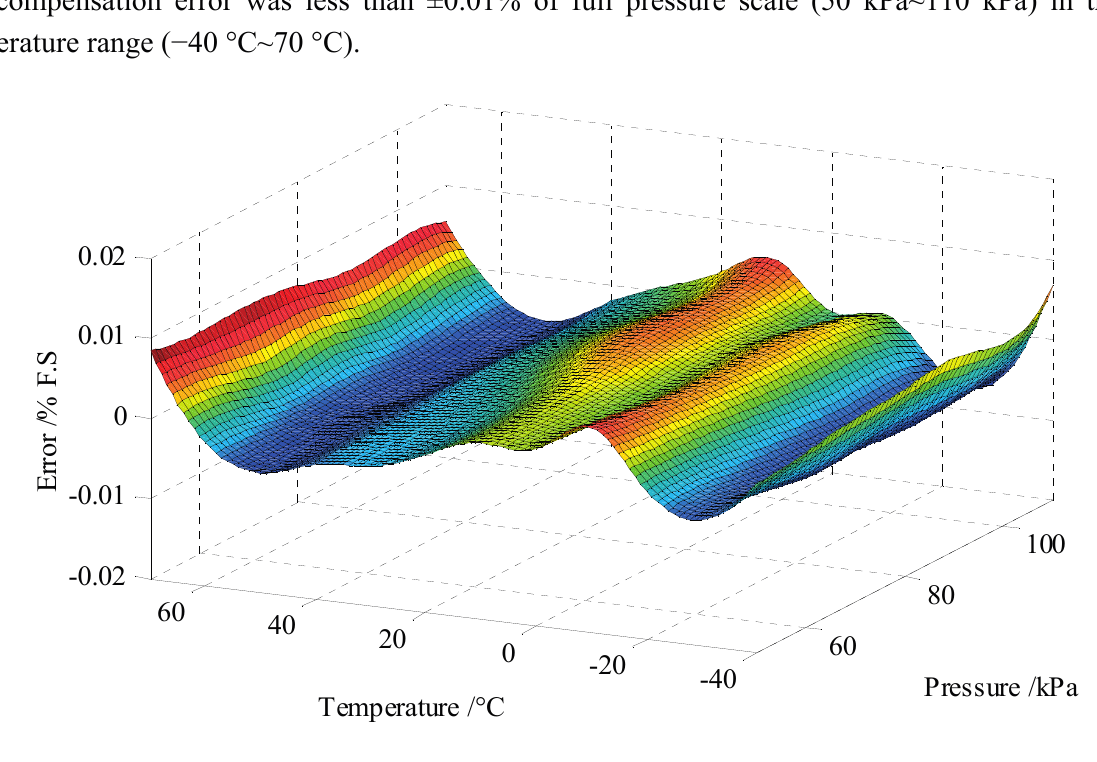
Figure 5. Surface plot of the pressure compensation error as a function of temperature and pressure, which is less than ±0.01% F.S. (pressure range of 50 kPa to 110 kPa and temperature range of − 40 °C to 70